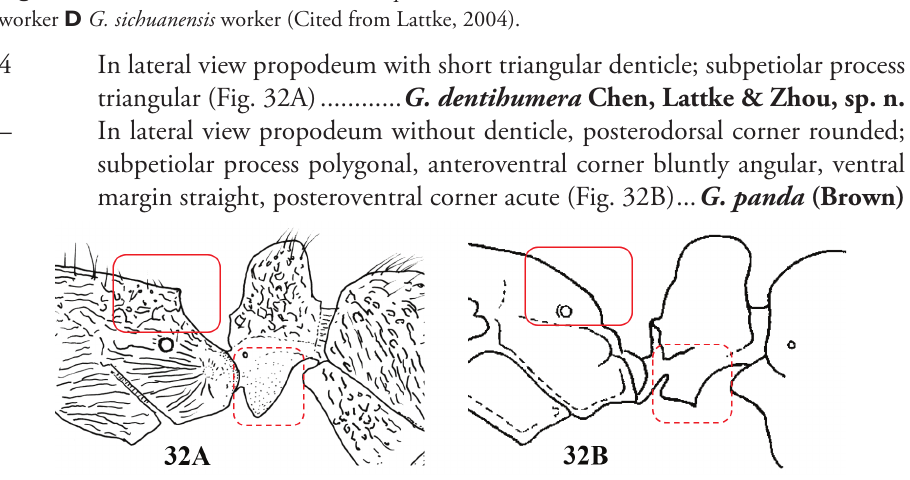
Figure 32. A G. dentihumera worker B G. panda worker (Cited from Lattke, 2004).